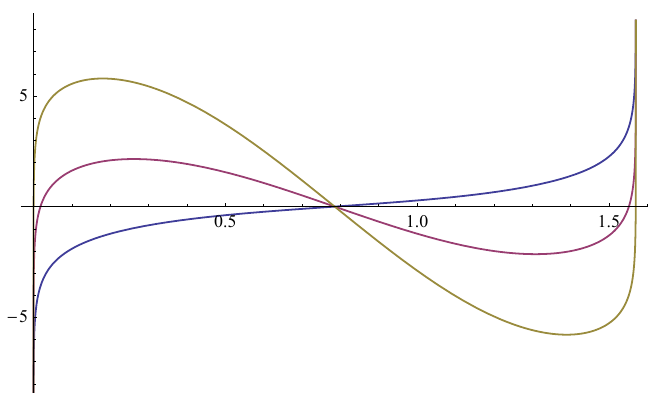
√ β ( x − x 0 ) as a function of βφ/ 4 for